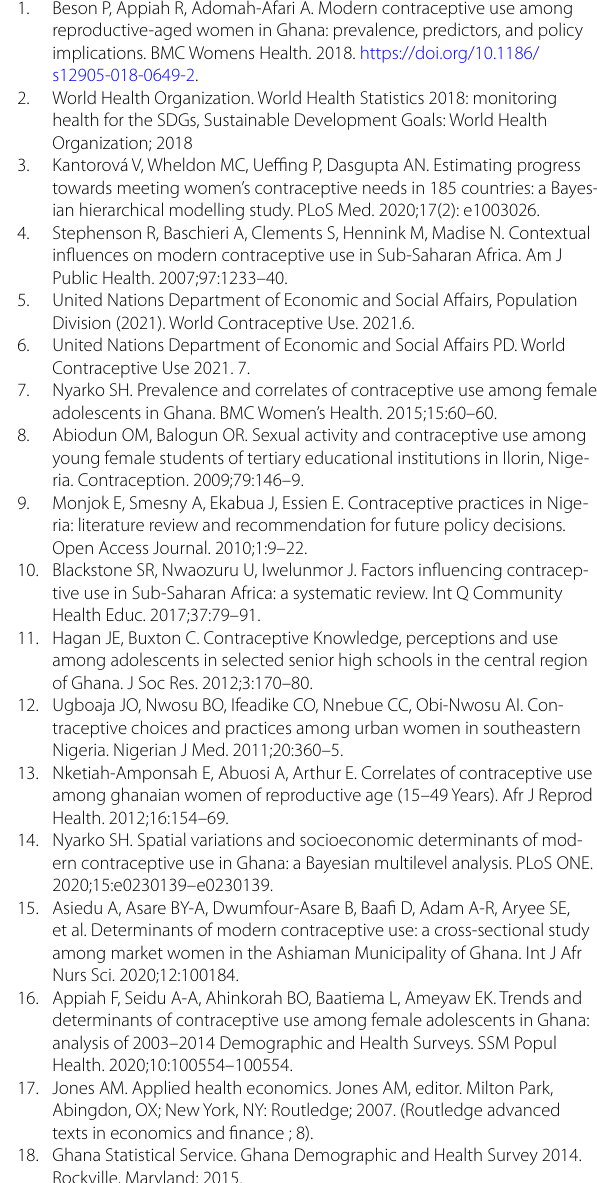
Table F. Determinants of modern contraceptive